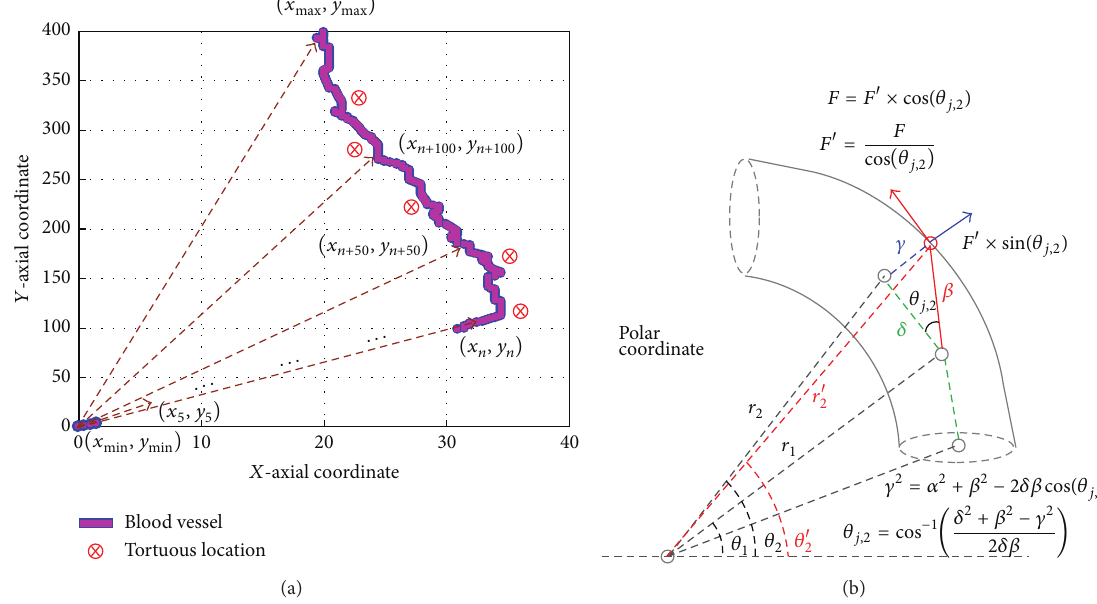
Figure 4: (a) Image coordinates of blood vessel, (b) image polar coordinates of tortuous blood vessel.